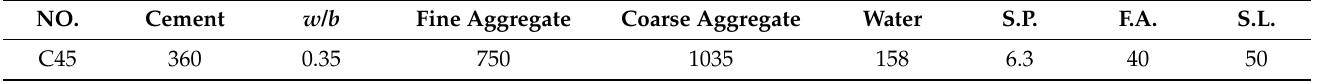
Table 2. Mix proportions of lining concrete (kg/m 3